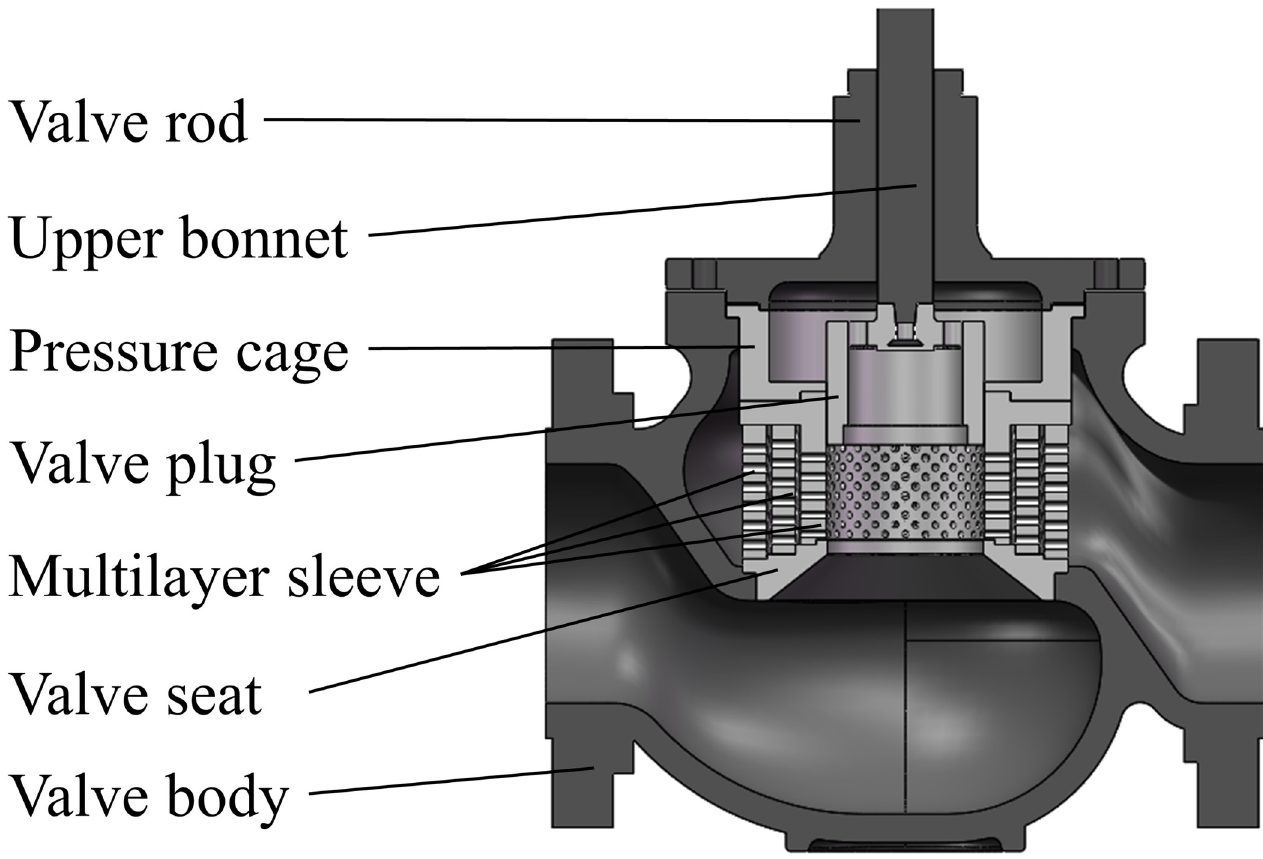
Fig 1. The structure of multistage pressure reducing valve.